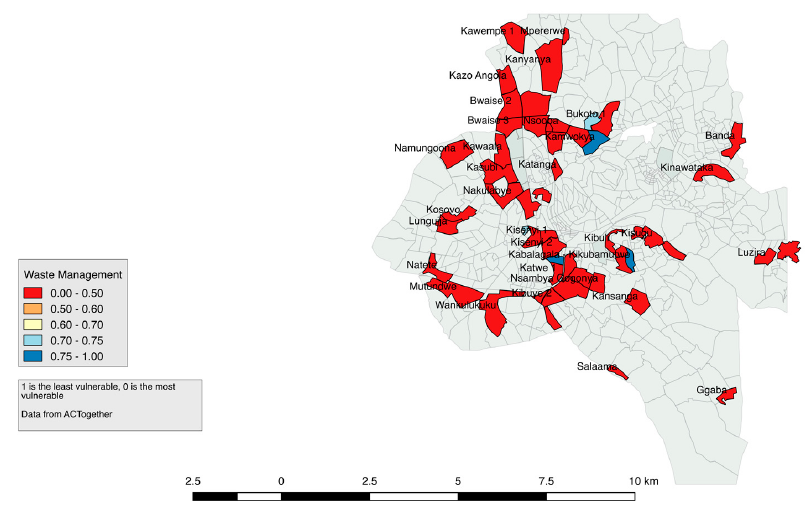
Figure 5. Waste Management Vulnerability; Created with QGIS using variables in Table 1. 54 out of 57 slum communities have a water vulnerability score of under 0.75 (1 is least vulnerable and 0 is most vulnerable). The geographical units portrayed are Ugandan village boundaries.